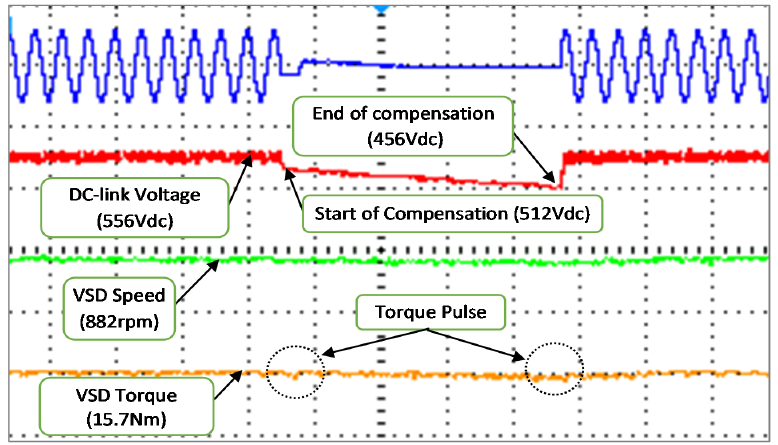
Figure 14. Experimental results with dc-link voltage compensation.